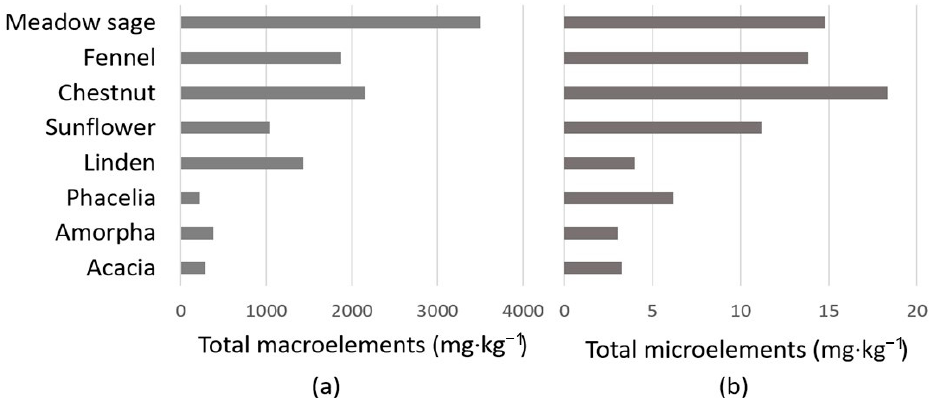
Figure 2. Reported average concentrations of ( a ) macroelements and ( b ) microelements in the studied